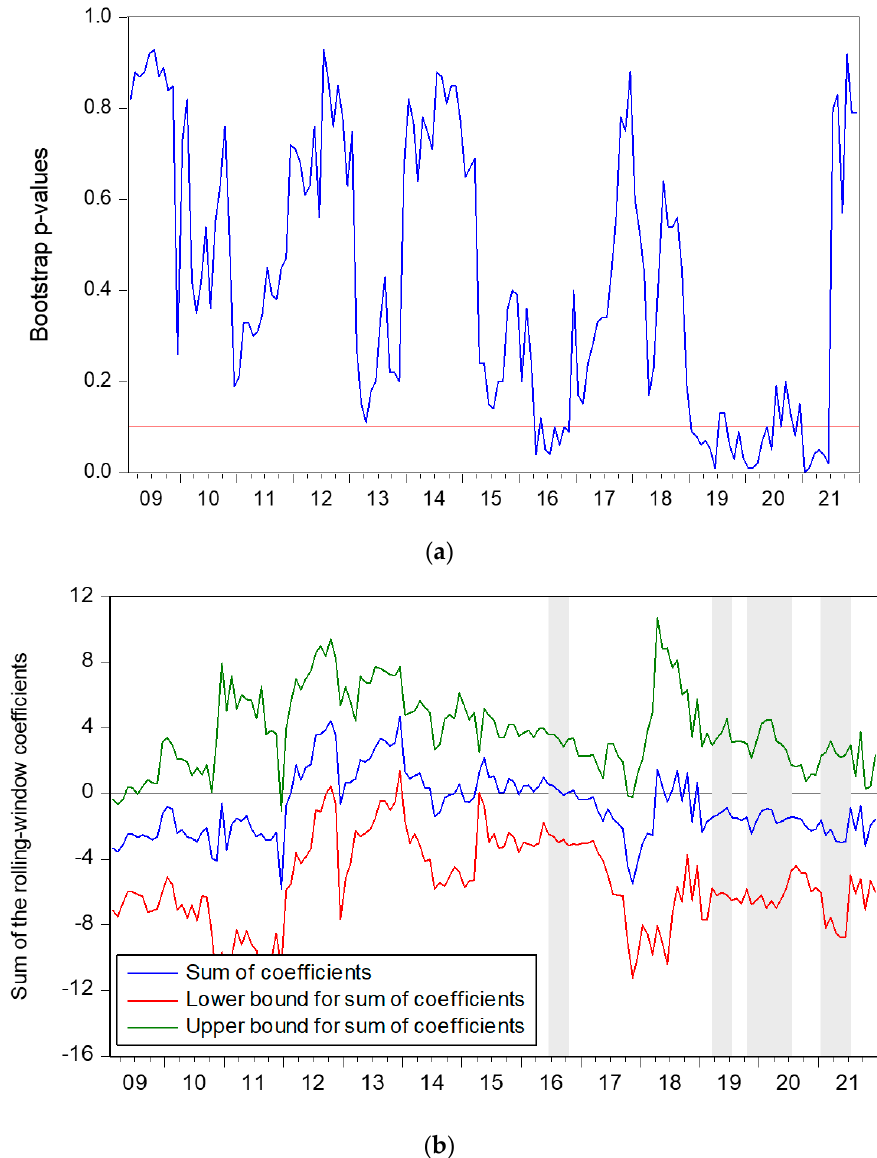
Figure 3. Impact of SP on FE. ( a ) Bootstrap p -values of rolling test statistic testing. ( b ) Impact of SP on FE.